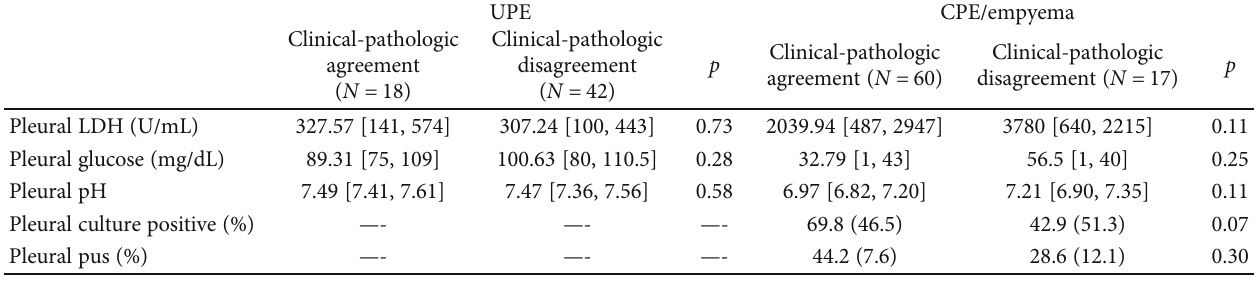
Table 2: Pathology agreement with clinical markers. Values are expressed as mean (SD) for normally distributed variables and mean (interquartile range) for nonnormally distributed